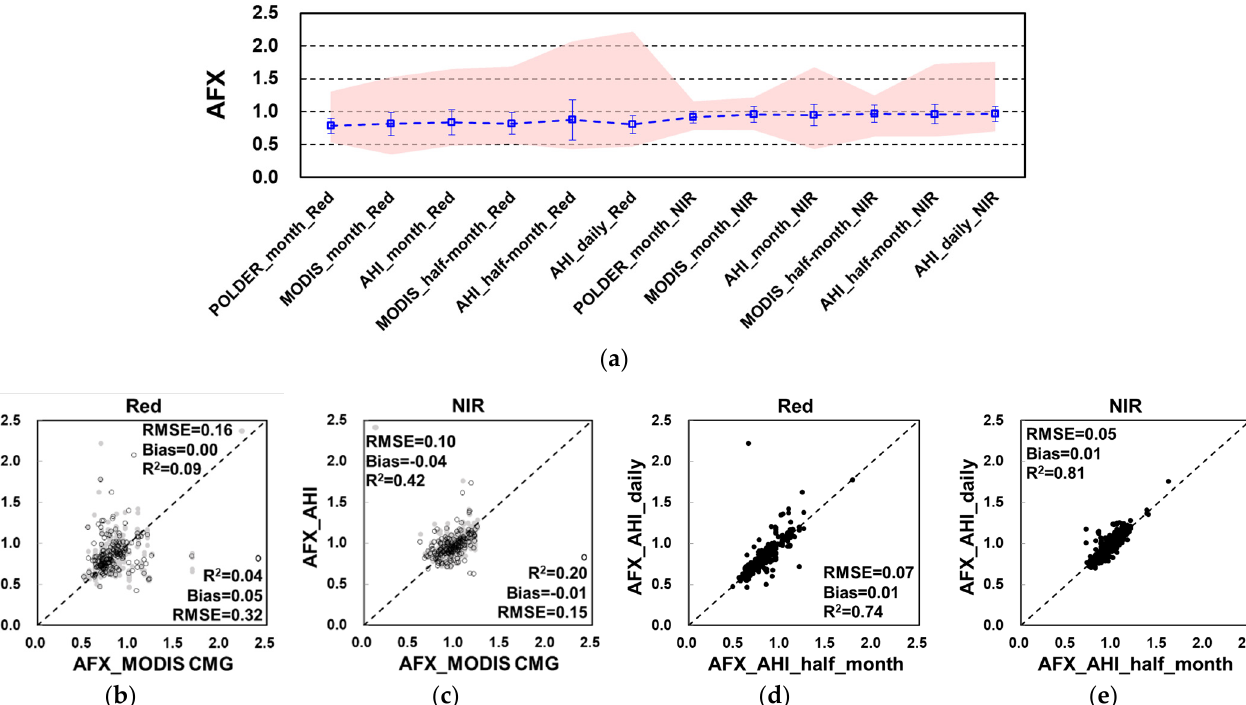
Figure 10. Comparison of AFXs that were retrieved from the accumulated observations of POLDER, MODIS CMG, and AHI during a day and half a month. ( a ) refers to the variance ranges of AFX that were retrieved from accumulated multiangle observations of the three sensors at different time spans. ( b ) refers to comparisons of AFX that were retrieved from half-month (black circle) and daily (grey dot) AHI data with those from half-month MODIS data in the red band, and ( c ) is similar to ( b ) but in the NIR band. ( d , e ) refers to comparisons of AFX that were retrieved from AHI data between the half-month scale and daily scale in the red and NIR bands, respectively.